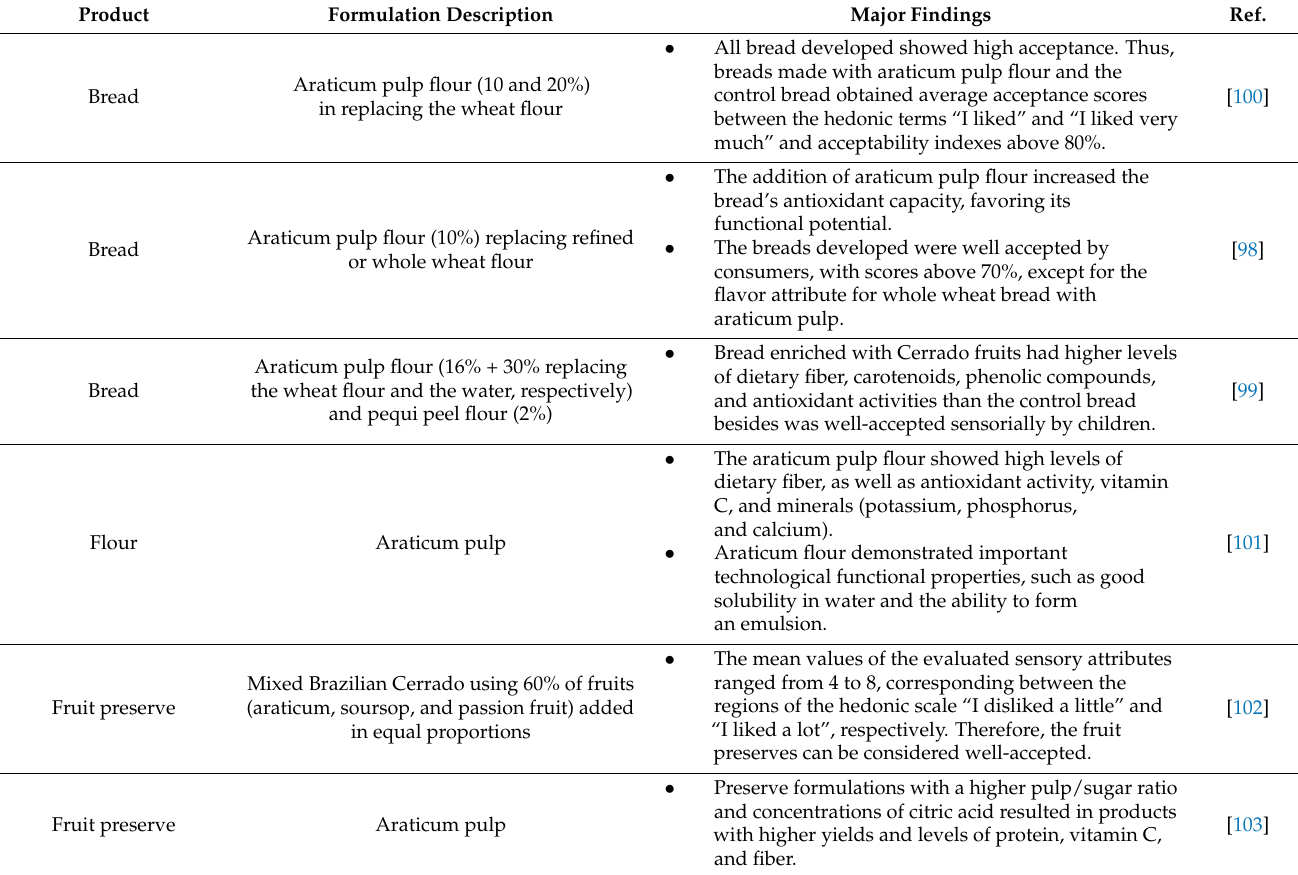
Table 3. A summary of studies showing the use of araticum fruit in the development of food products. Product Formulation Description Major Findings